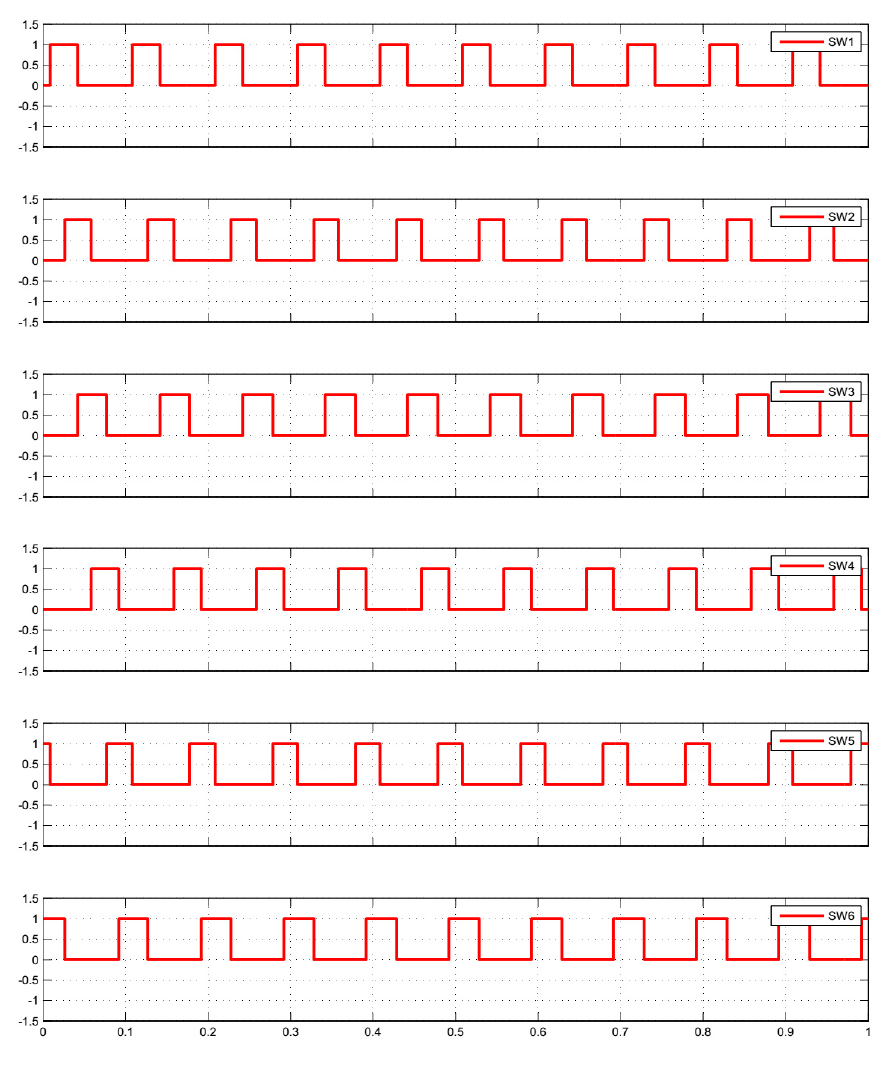
Figure 14. Controller output pulses (zero–one).